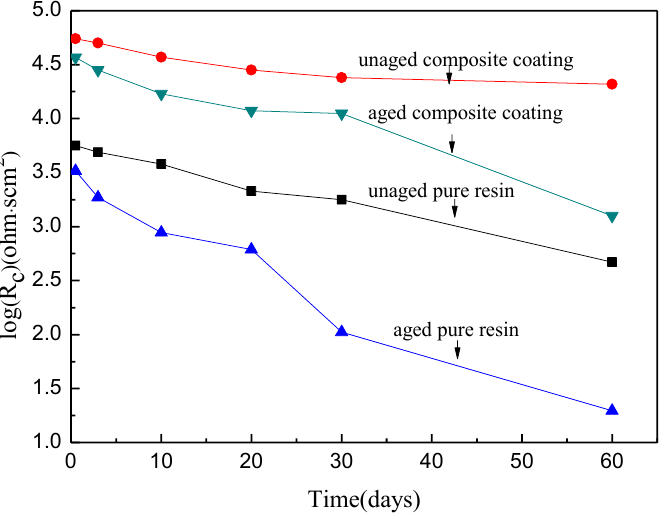
Figure 11. The coating resistance variation of pure epoxy resin and composite with time.